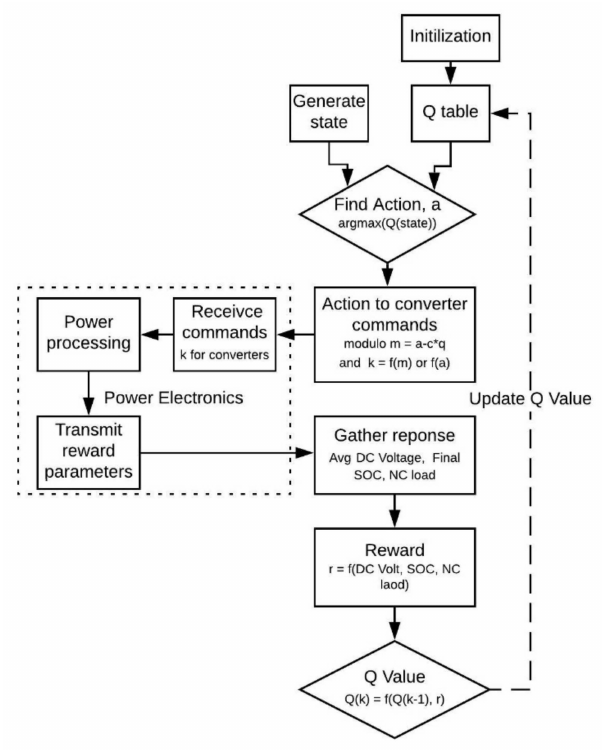
Figure 6. Flow chart—implementation of